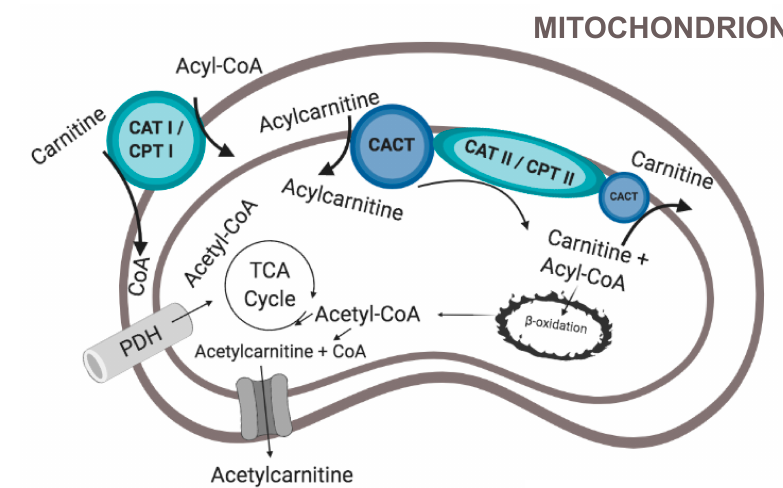
Figure 2. The L-carnitine shuttle. L-carnitine binds to acyl-CoA to help transportation to the mitochondria for β -oxidation. L-carnitine also binds to excess acetyl-CoA to be exported from the mitochondria. The outer mitochondrial membrane contains Carnitine Acyltransferase I/Carnitine Palmitoyl Transferase (CAT I/CPT I), that binds L-carnitine to acyl-CoA. Acyl-carnitine can then enter the intermembrane space of the mitochondria. The inner mitochondrial membrane contains Carnitine Acyl Carnitine Translocase (CACT), which both can transport acyl-carnitine into the mitochondrial matrix, and can export L-carnitine. The inter mitochondrial membrane also contains Carnitine Acyl Transferase II/Carnitine Palmitoyl Transferase II (CAT II/CPT II), which can separate L-carnitine from the acyl-CoA, so that it can undergo β -oxidation. L-carnitine can also bind to acetyl-CoA forming acetyl-carnitine in the mitochondrial matrix, which allows for export of acetyl-CoA, if not used for oxidative phosphorylation or ketone production. Figure created in BioRender.com.